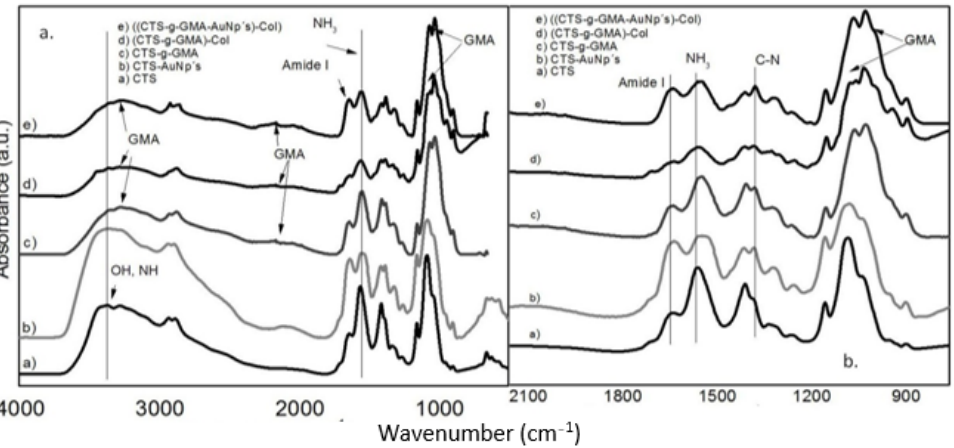
Figure 5. ( a ) FTIR spectrum obtained for pure chitosan (CTS), nanocomposites with chitosan and gold nanoparticles CTS-AuNPs; chitosan, and glycidyl methacrylate (CTS-g-GMA); chitosan, glycidyl methacrylate, and type I collagen (CTS-g-GMA)-Col; and a nanocomposite (CTS-g-GMA-AuNPs)-Col; ( b ) zoom of the region of greatest contribution between 1700 to 900 cm − 1 . The relative intensity of the primary amide group related to stretching vibration of C=O bonds at 1650 cm − 1 decreased, especially for (CTS-g-GMA)-Col and ((CTS-g-GMA- AuNPs)-Col nanocomposites. The bending vibration of NH 2 at 1550 cm − 1 showed a de- crease in relative intensity and a redshift for composite samples compared with pure CTS.